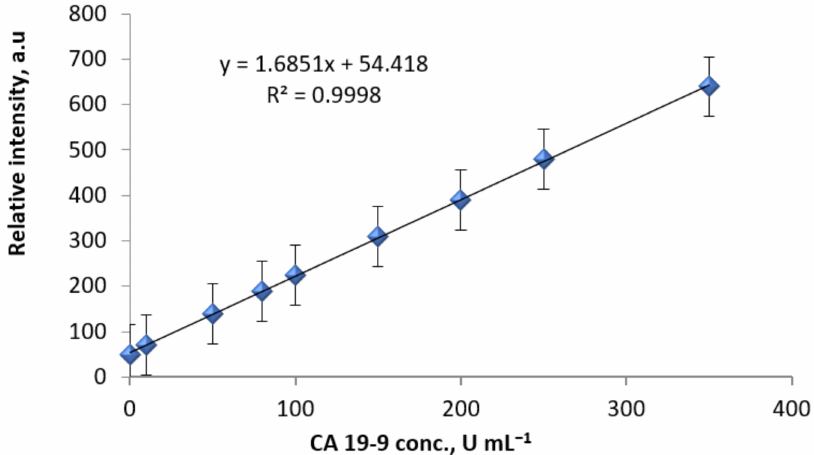
Figure 8. A calibration graph for the detection of CA 19-9 antigen using immobilized CQDs/Au–Ab–HRP immunoassay fluorescence